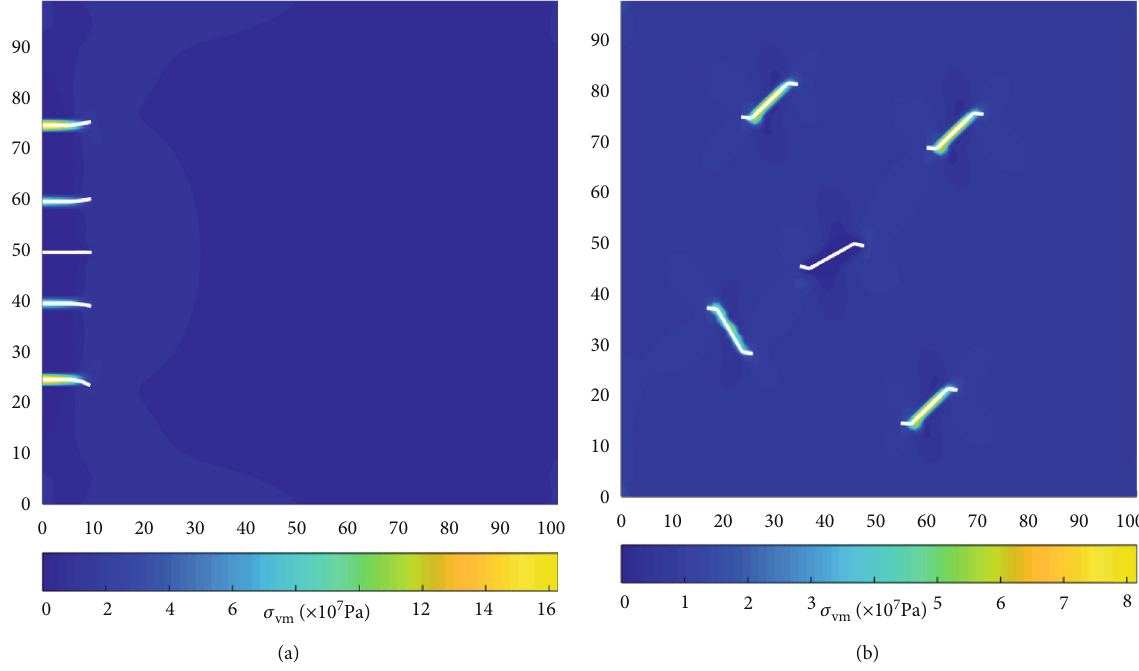
Figure 12: Shaded plots of the von Mises stress σ vm for the multiple-crack example: (a) 5 parallel edge cracks (case 1); (b) 5 randomly located cracks (case 2) (lengths in m).